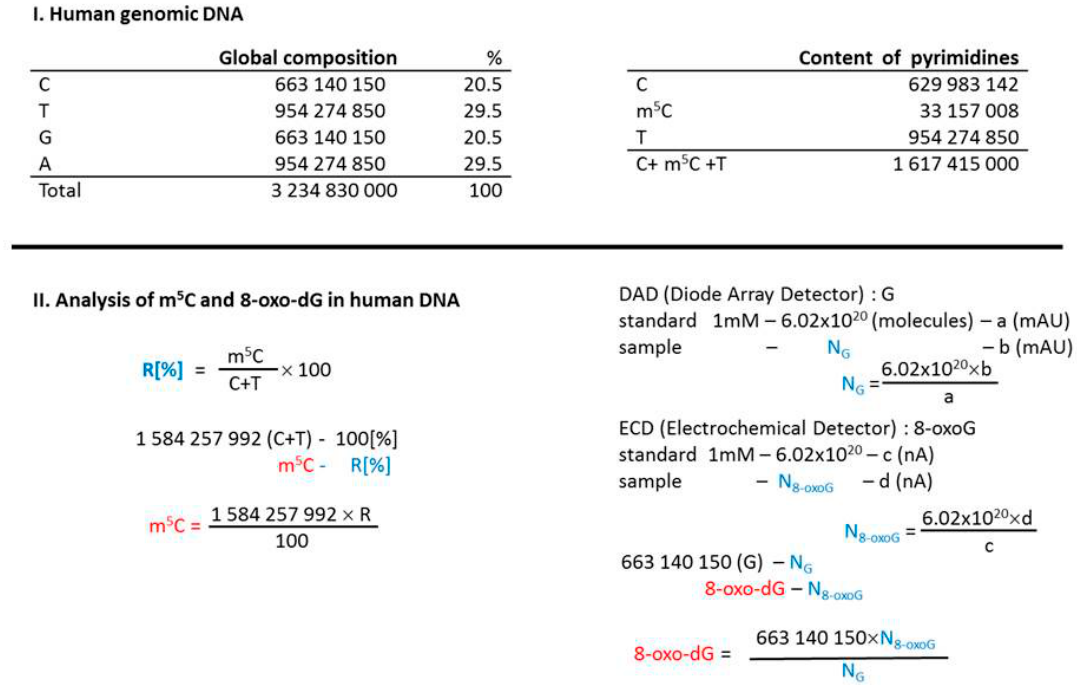
Figure 1. Calculations leading to determine the 5-methylcytosine (m 5 C) and 8-oxo-deoxyguanosine (8-oxo-dG) contents in examined DNA samples. Human genomic DNA composition data were taken from [27].